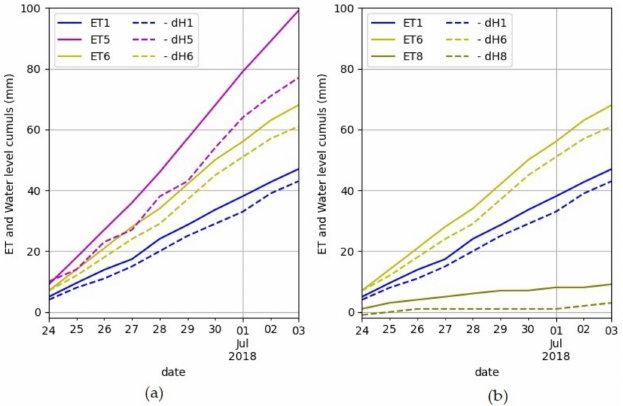
Figure 8. Cumulative curves during a summer period (24 June to 3 July 2018) for evapotranspirations (ET) and water level variations (dH) in the internal water storage (IWS). The herbaceous lysime-ters (1 and 6) are compared with the spontaneous vegetation lysimeter (5) ( a ) and, the regularly removed vegetation one (lysimeter 8) ( b ). Note that for this period, the data for shrubs (2, 7) are not